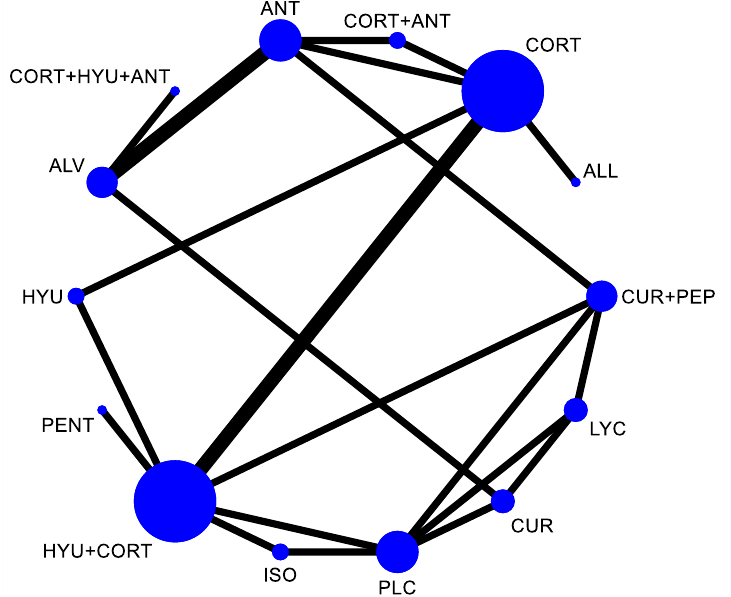
Figure 5. Network plot comparing the comparative efficacy of interventions used in the manage- ment of OSMF (burning sensation). Abbreviations: HYU—hyaluronidase; CORT—corticosteroid; LYC—lycopene; ALL—allicin; ANT—antioxidant; CUR—curcumin; ALV—aloe vera; PEP—piperine; PLC—placebo; ISO—isoxsuprine;